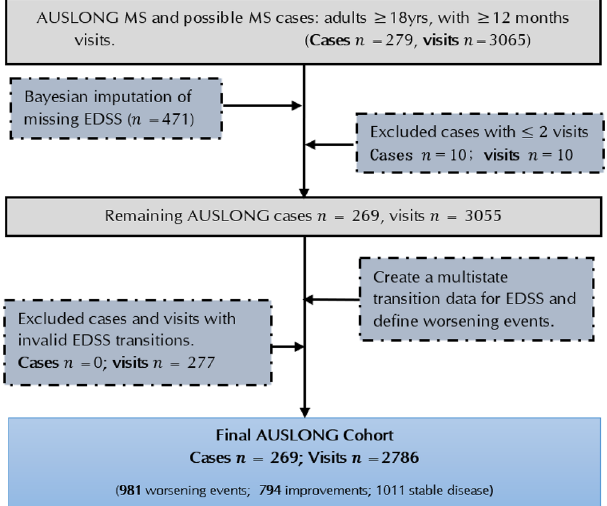
Figure 1. A flow chart of AUSLONG data extraction and case selection